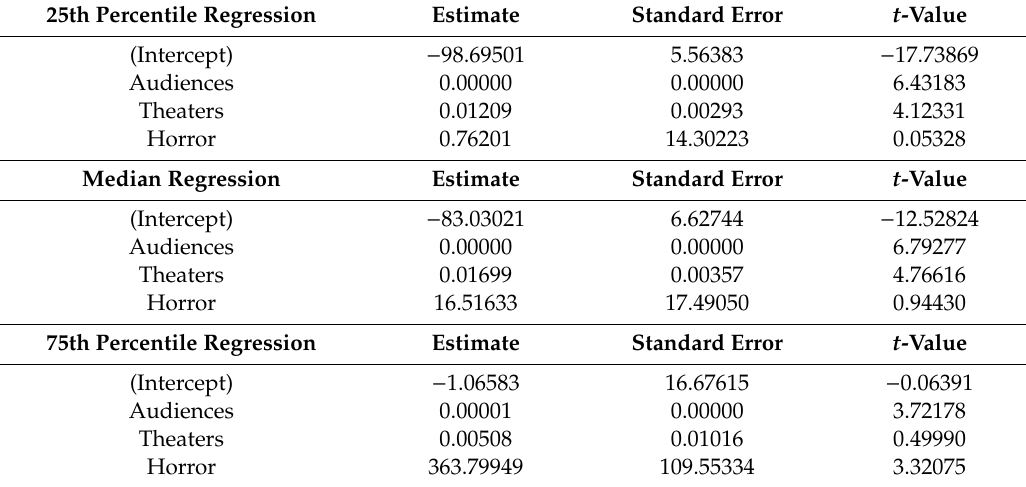
Table 5. Quantile Regression of ROI with 2010–2015 Years data.